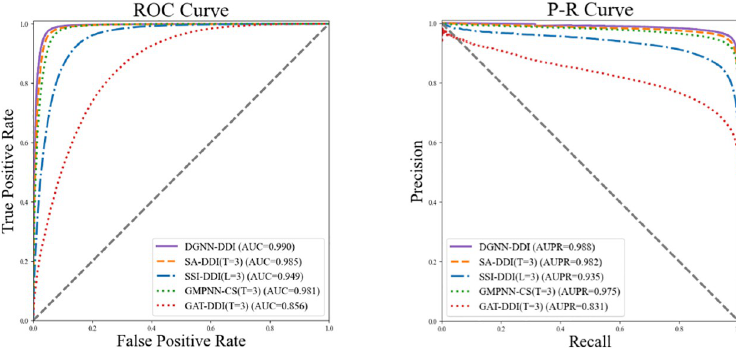
Fig 3. The ROC curves and P-R curves of all models, where T = 3 or L = 3 for all